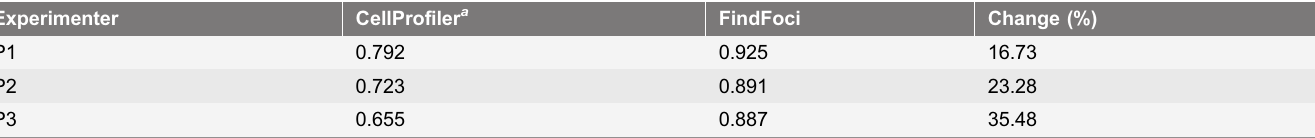
Table 5. FindFoci outperforms CellProfiler a